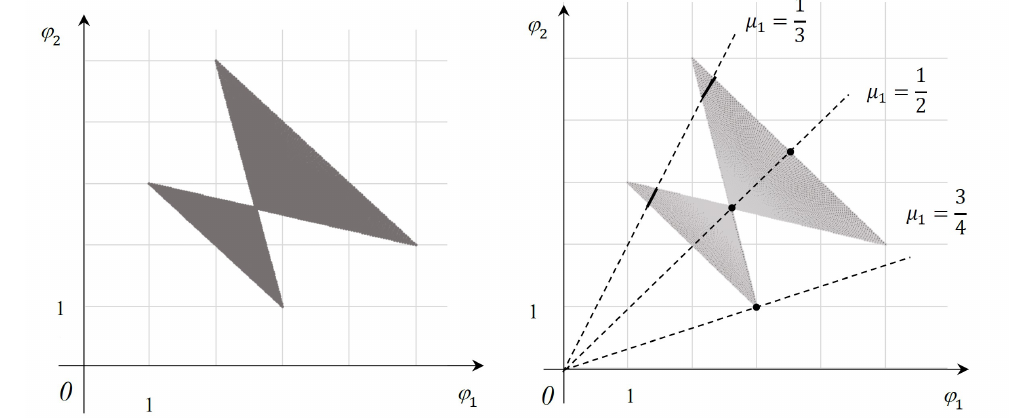
Figure 4. Game (17). The feasible set (on the left) and the sets of equilibrium values (in bold) for some scalar games Γ G ( µ ) (on the